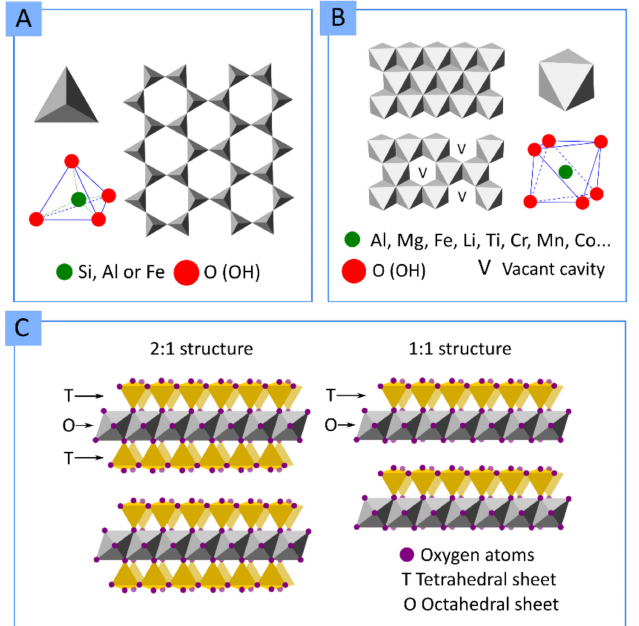
Figure 1. Schematic representation of ( A ) basic phyllosilicate tetrahedron and spatial disposition of tetrahedral sheets and ( B ) octahedron and spatial disposition of octahedral sheets. ( C ) Phyllosilicates layer structures 2:1 (T:O:T) and 1:1